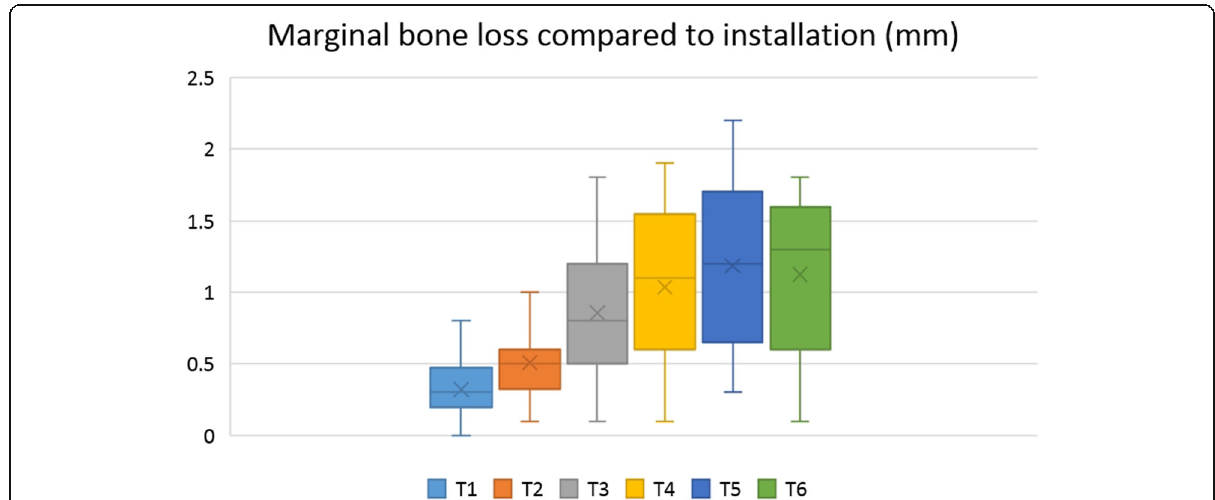
Fig. 6 Marginal bone loss (MBL) for each follow-up period compared to MBL at installation. T1: 3months after installation, T2: at prosthetic loading, T3: 1year after installation, T4: 2years after installation, T5: 3years after installation, T6: 5years after installation. Mean MBL at 3months, prosthetic loading, and 1year, 2years, 3years, and 5years after installation was significantly higher than MBL at the time of implant installation ( p <0.05)